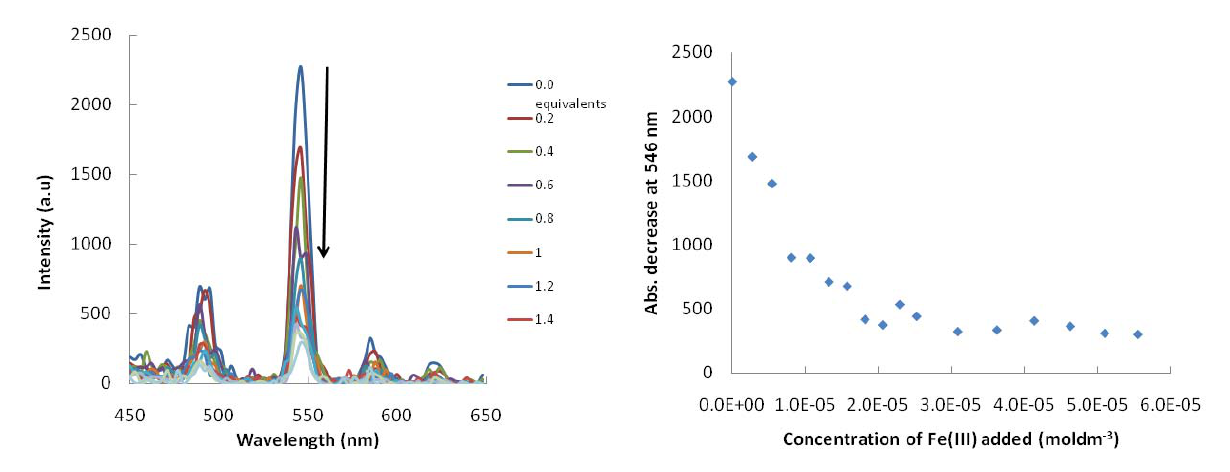
Figure 5. Fluorescence titration with 4 and FeCl RHS: Binding isotherm obtained showing the decrease in absorbance at 546 nm on the addition of